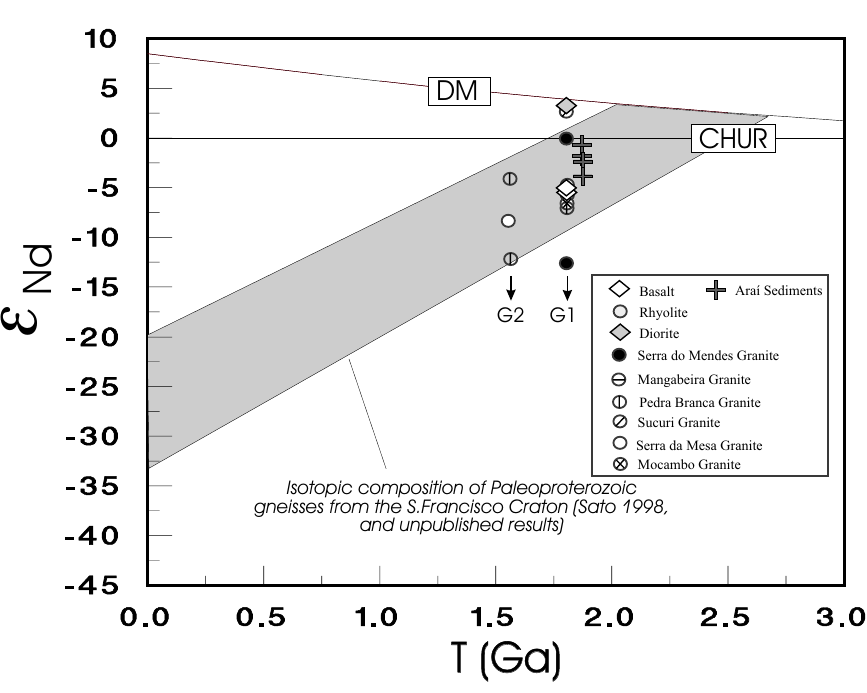
Fig. 5 – Nd isotopic composition of the granites, and Araí supracrustals, compared to the com- position of Paleoproterozoic rocks of the São Francisco